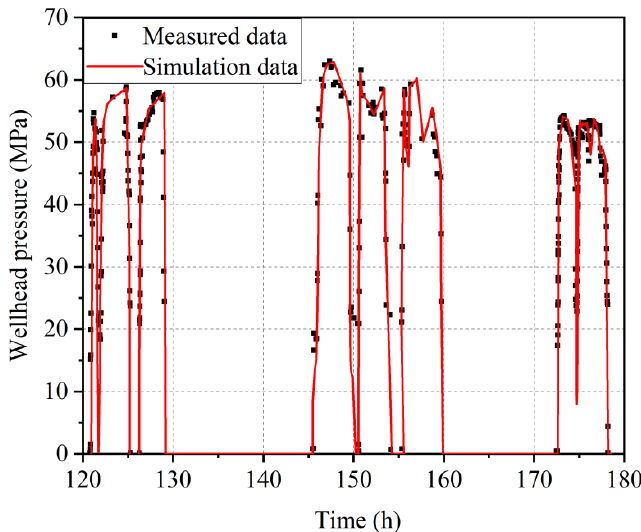
Figure 8. Comparison of measured and simulated results of reservoir stimulation in the third stage.